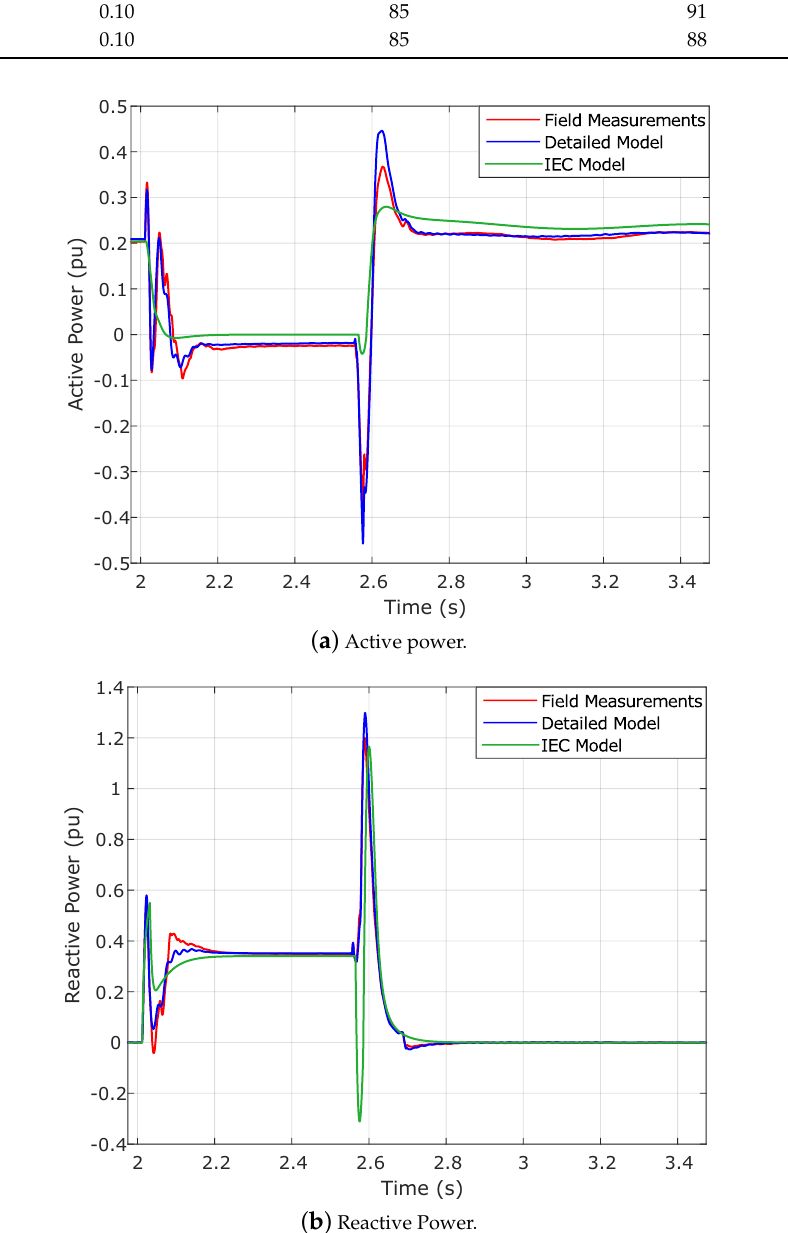
( b ) Reactive Power. Figure 8. Active and reactive power at measurement point 2 (690 V). WT operating at partial load